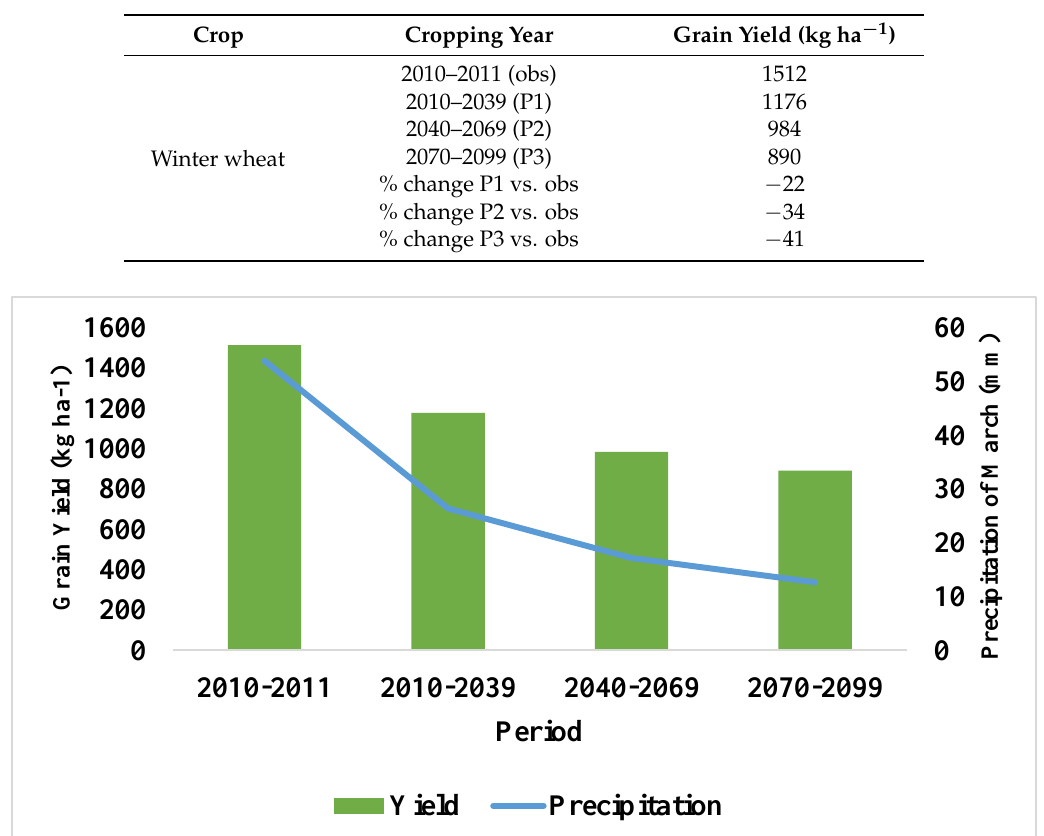
Table 10. Results of the dryland winter wheat yield predictions for the periods 2010–2039, 2040–2069, and 2070–2099.